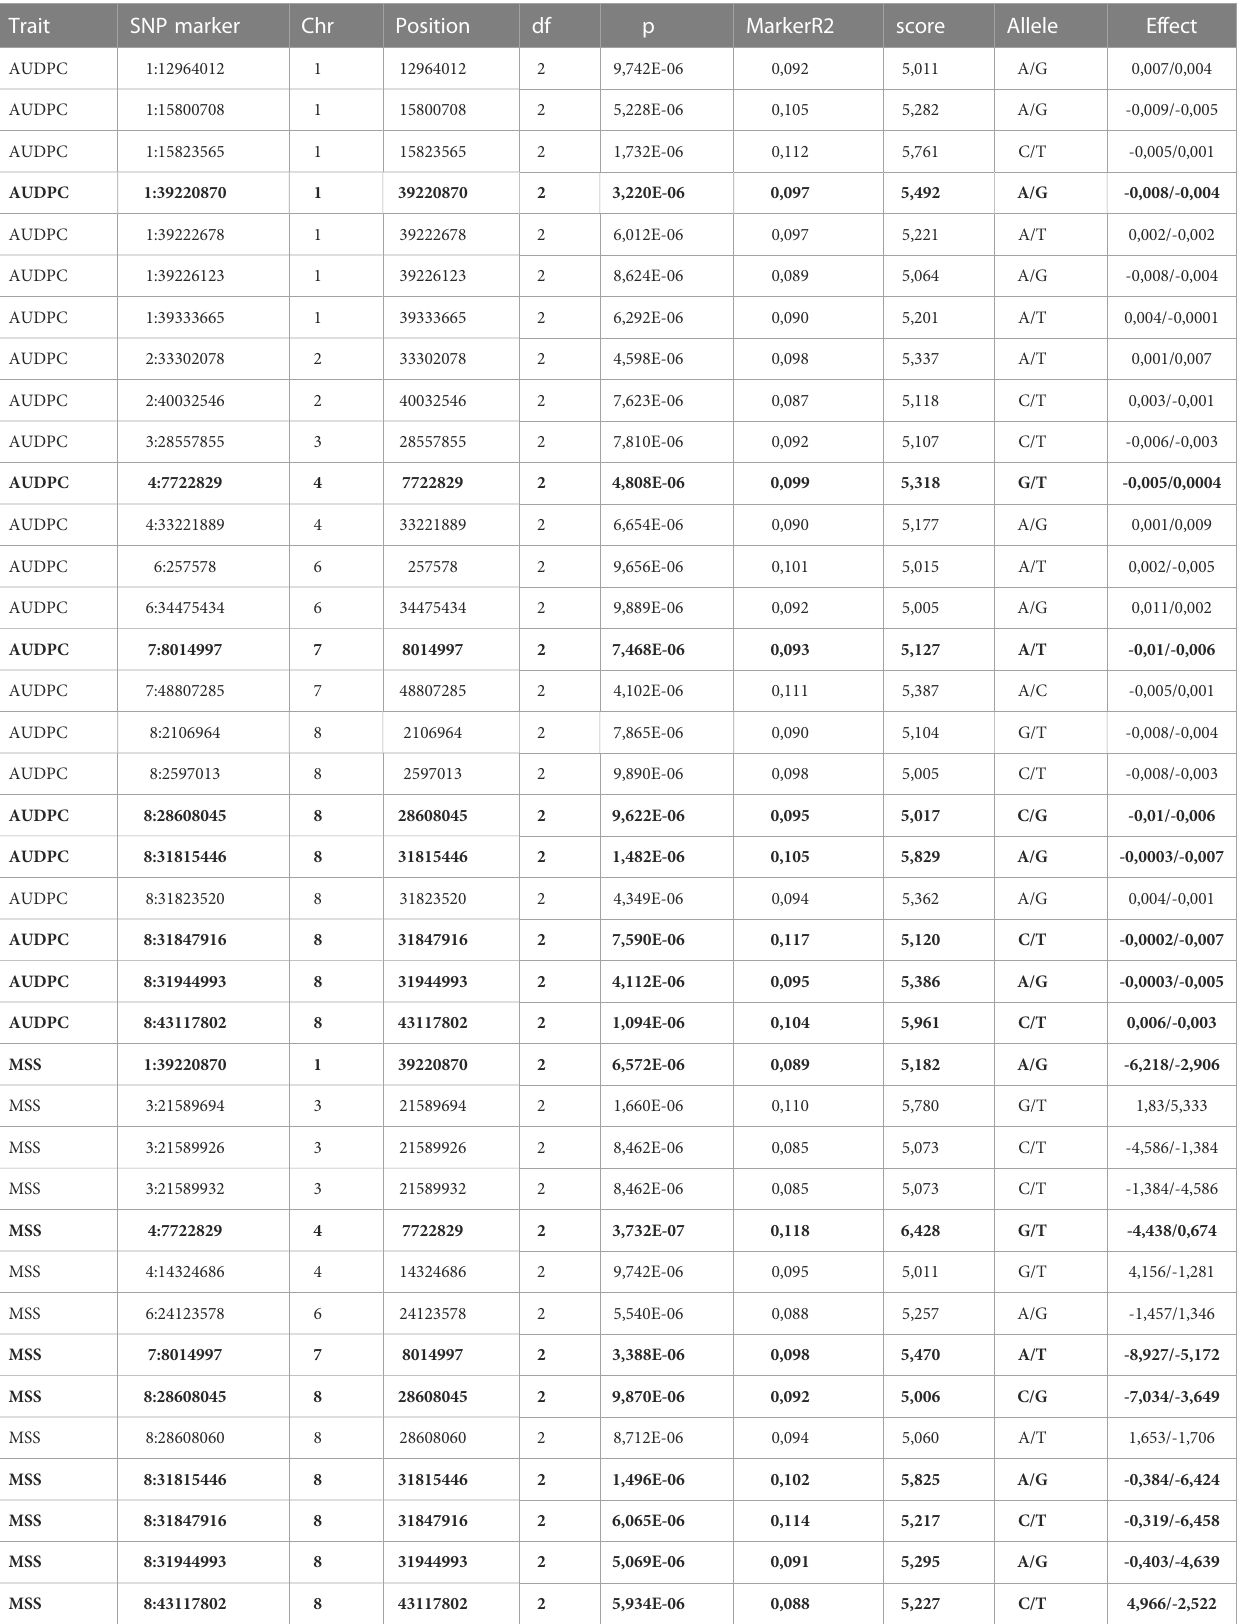
TABLE 2 Most signi fi cant Single Nucleotide Polymorphism (SNP) markers associated to the response of Medicago truncatula to Verticillium alfalfae strain AF1.